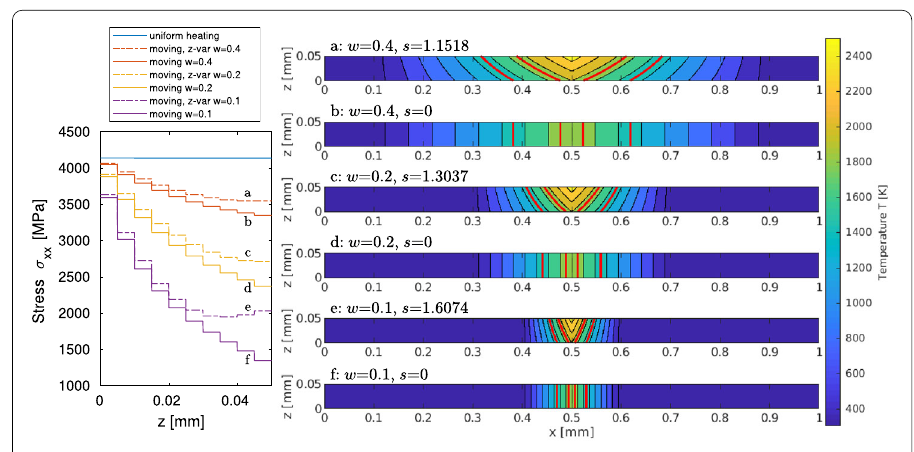
Fig. 12 Two-dimensional example. Left: final stress σ xx over height z (zero is constrained bottom) at x = 0 . 5mm depending on width of temperature peak and (possibly) z -variation. Solid lines represent moving temperature profiles, dashed lines represent moving and z -varying temperature profiles. Right: snapshots of temperature profiles a – f which induce the associated final stress response on the left. Solidus and liquidus isotherms indicated in